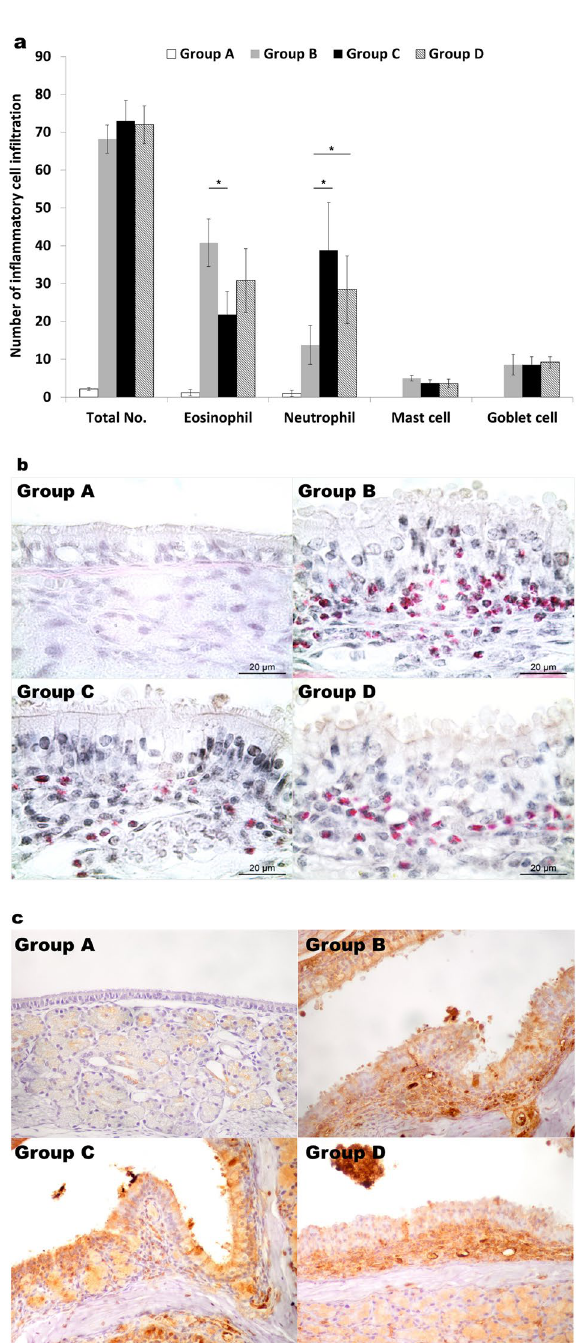
Figure 2. Histologic results of inflammatory cell infiltrations. ( a ) Inflammatory cell infiltrate profile of the different experimental groups. The data was plotted using Microsoft’s PowerPoint 2016 (https ://www.micro soft.com). ( b ) Sirius red staining for eosinophils and ( c ) anti-neutrophil antibody staining. Group A: negative control, Group B: positive control, Group C: LPS stimulation, Group D: poly(I:C) stimulation. *P <